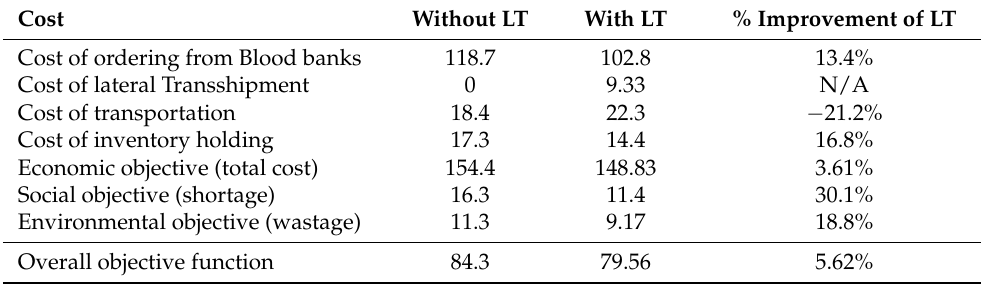
Table 7. Comparison of objective functions (in 1000$) with and without lateral transshipment.